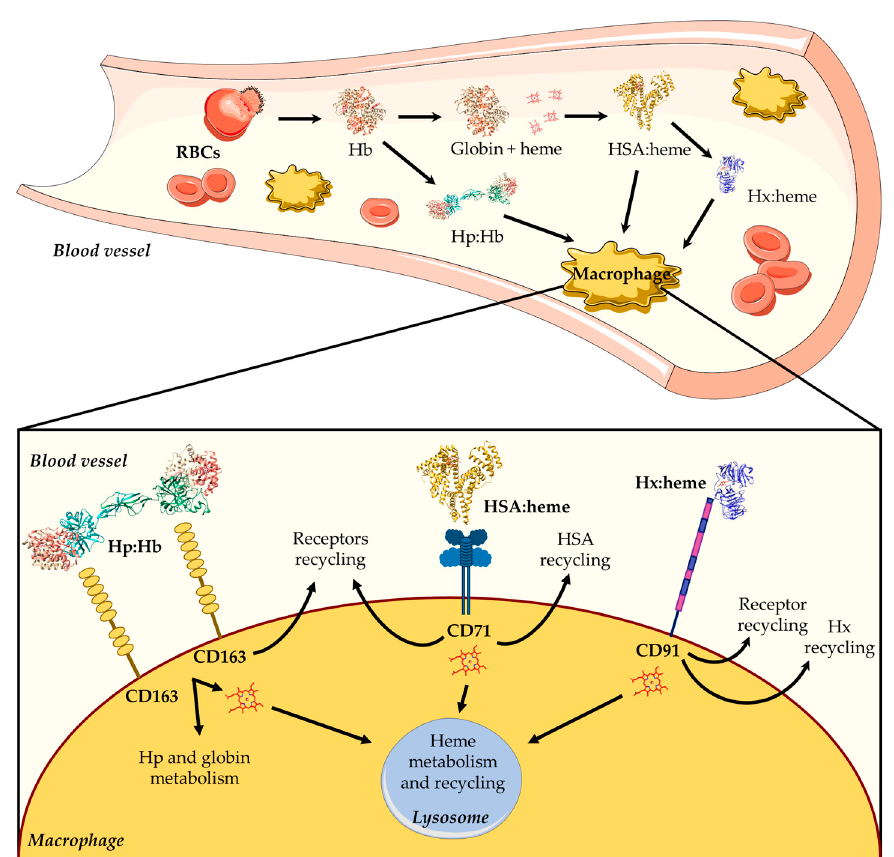
Figure 1. Overview of heme scavenging in blood vessels. The intravascular hemolysis of red blood cells (RBCs) induces the release of hemoglobin (Hb), which is scavenged by high-density lipoproteins (HDLs), low-density lipoproteins (LDLs), human serum albumin (HSA), and hemopexin (Hx). First, the free heme binds to HDL and LDL, then it moves to HSA, and lastly it is transferred to Hx. The HSA:heme complex [31] is internalized by the CD71 receptor, whereas the Hx:heme complex [32] binds to the CD91 receptor and is then moved into macrophages. The figure has been partially generated through the website Servier Medical Art licensed under a Creative Commons Attribution 3.0 imported license. The three-dimensional structures of Hb (PDB ID: 1JY7) [33], Hp:Hb (PDB ID: 4F4O) [34,35], HSA:heme (PDB ID: 1N5U) [31], and Hx:heme (PDB ID: 1QJS) [32] complexes have been drawn using UCSF-Chimera